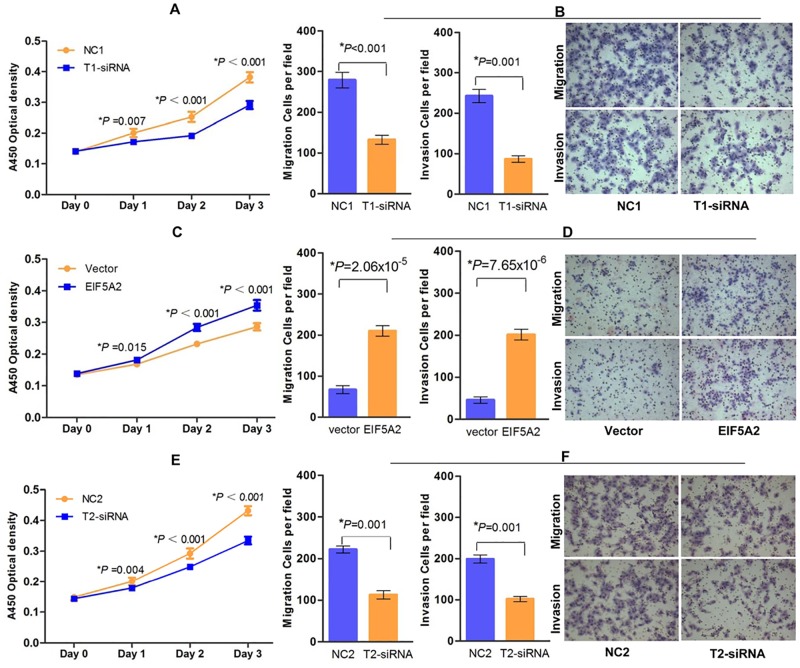
EIF5A2 or MTA1 expression levels influenced the aggressiveness of GC cells in vitro.(A) Proliferation of EIF5A2-targeted siRNA (T1-siRNA) and non-targeted control (NC) HGC27 cells were measured by CCK-8 assay every 24 h after siRNA transfection. (B) Cell migration and invasion were decreased following transfection of T1-siRNA into HGC27 cells (Student’s t-test, P<0.001 and P = 0.001, respectively). Column, mean; bars, ±SD (from triplicates). (C) Proliferation of EIF5A2-plasmid and control plasmid MKN45 cells were measured by CCK-8 assay every 24 h after plasmid transfection. (D) Cell migration and invasion were increased following transient transfection of EIF5A2-plasmid into MKN45 cells (Student’s t-test, P = 2.06×10-5 and P = 7.65×10-6, respectively). Column, mean; bars, ±SD (from triplicates). Image insert (B right and D right) shows a representative field of view from each treatment. (E) Proliferation of MTA1-targeted siRNA (T2-siRNA) and non-targeted control (NC2) HGC27 cells were measured by CCK-8 assay every 24 h after siRNA transfection. (F) Cell migration and invasion were decreased following transfection of T2-siRNA into HGC27 cells (Student’s t-test, both P = 0.001). Column, mean; bars, ±SD (from triplicates).